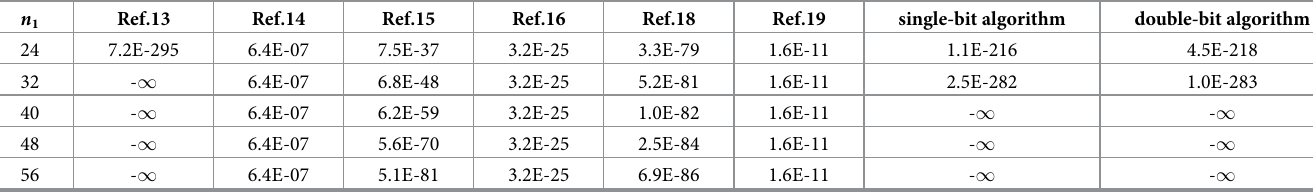
Table 4. Comparisons of the probability